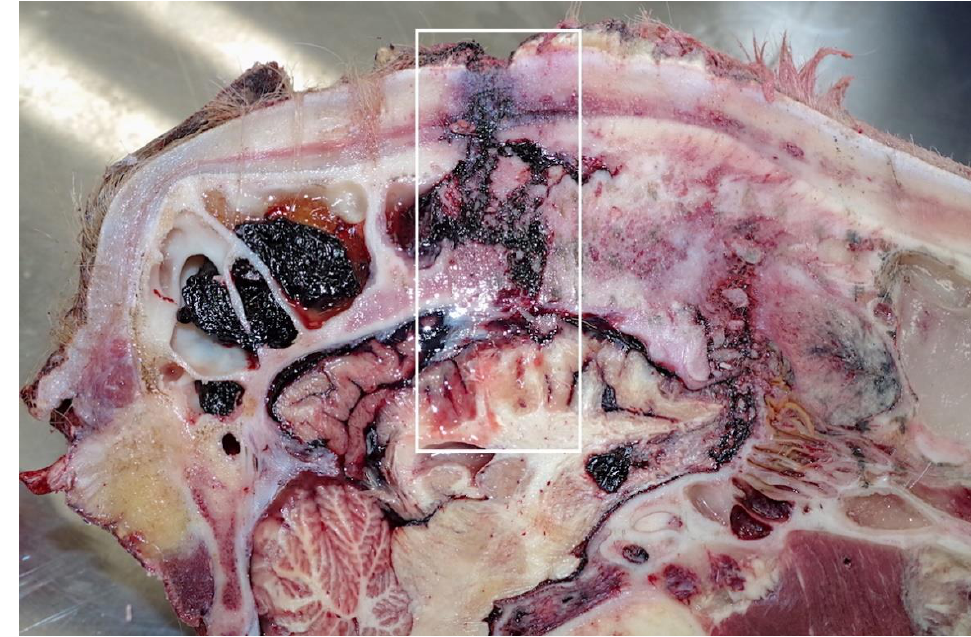
Figure 4. Shots 2–4. Left sagittal section .